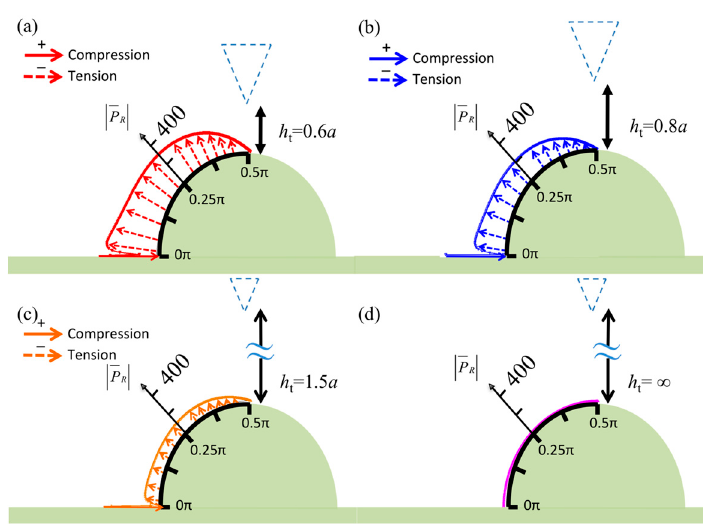
Figure 7. Normalized pressures in real part over the surface of the semicircular specimen when the diameter of the semicircle d = a and the tip height is ( a ) h t = 0.6 a , ( b ) h t = 0.8 a , ( c ) h t = 1.5 a , and ( d ) h t = ∞ .